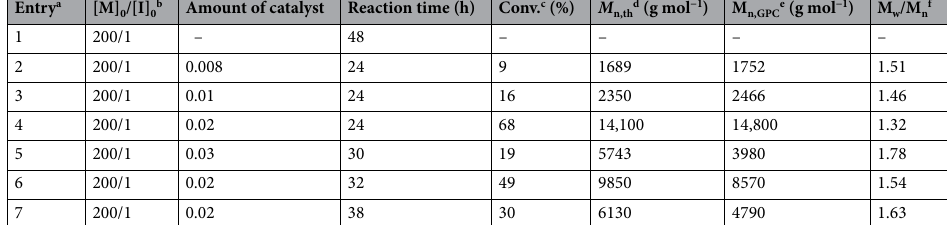
Table 1. ATRP reaction using Cu@CS-FP as a dip catalyst. a Polymerization conditions: MMA was used as a monomer, and EBiB was used as the initiator, dip catalyst, Monomer/solvent = 1/1 (v/v), N 2 atmosphere, T = 90 °C. b [M]: Monomer, [I]: Initiator. c Monomer conversion measured by gas chromatography. d Theoretical number average molecular weight (M n ), computed via monomer conversion. M theo = M initiator + α[M] 0 /[I] 0 ; α demonstrates monomer conversion. e M n determined by gel permeation chromatography. f Molecular weight